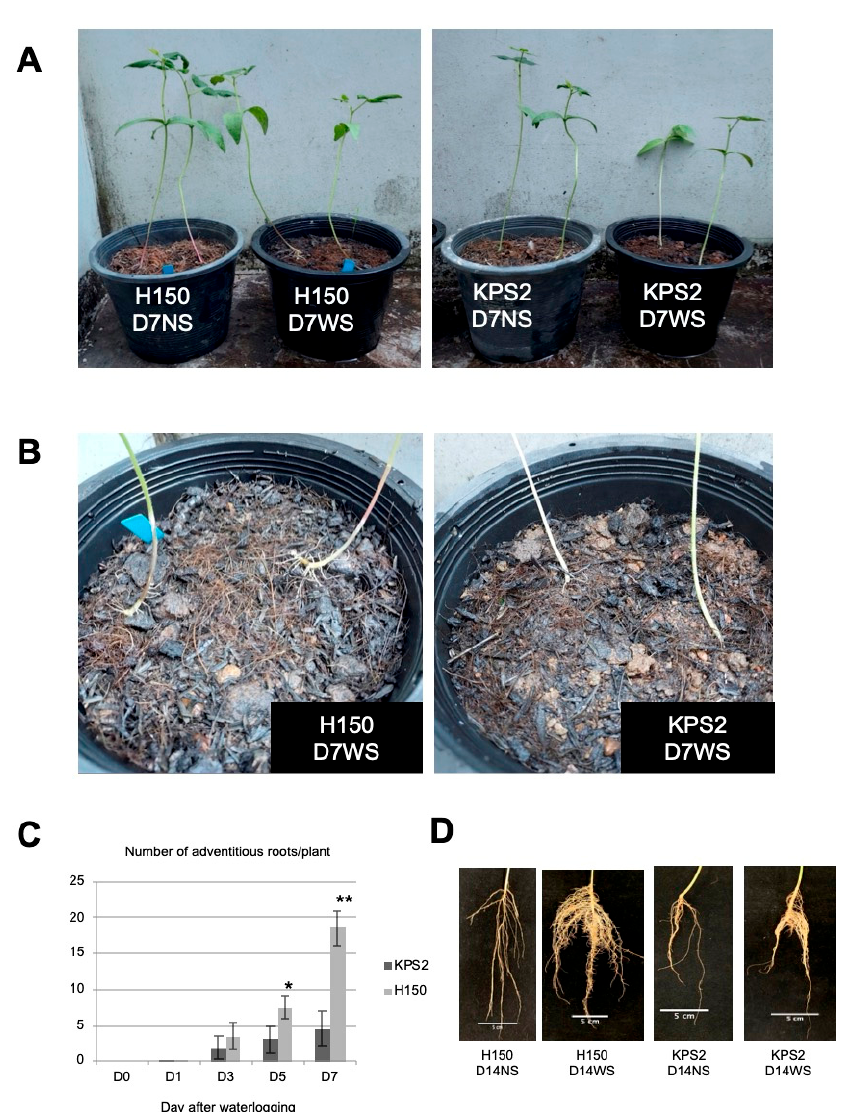
Figure 1. Contrasting phenotypes of H150 and KPS2 varieties under WS. ( A ) Representative 15-day- old seedlings subjected to 7 days (D7) of waterlogging (WS) or kept for 7 days under control (NS). ( B ) Formation of adventitious roots after seven days WS. ( C ) Time-course analysis of adventitious roots induced by WS. n = 8 plants; error bars = SE; * p < 0.05; ** p < 0.01 ( t -test). ( D ) Whole root phenotype under 14 days (D14) of WS.